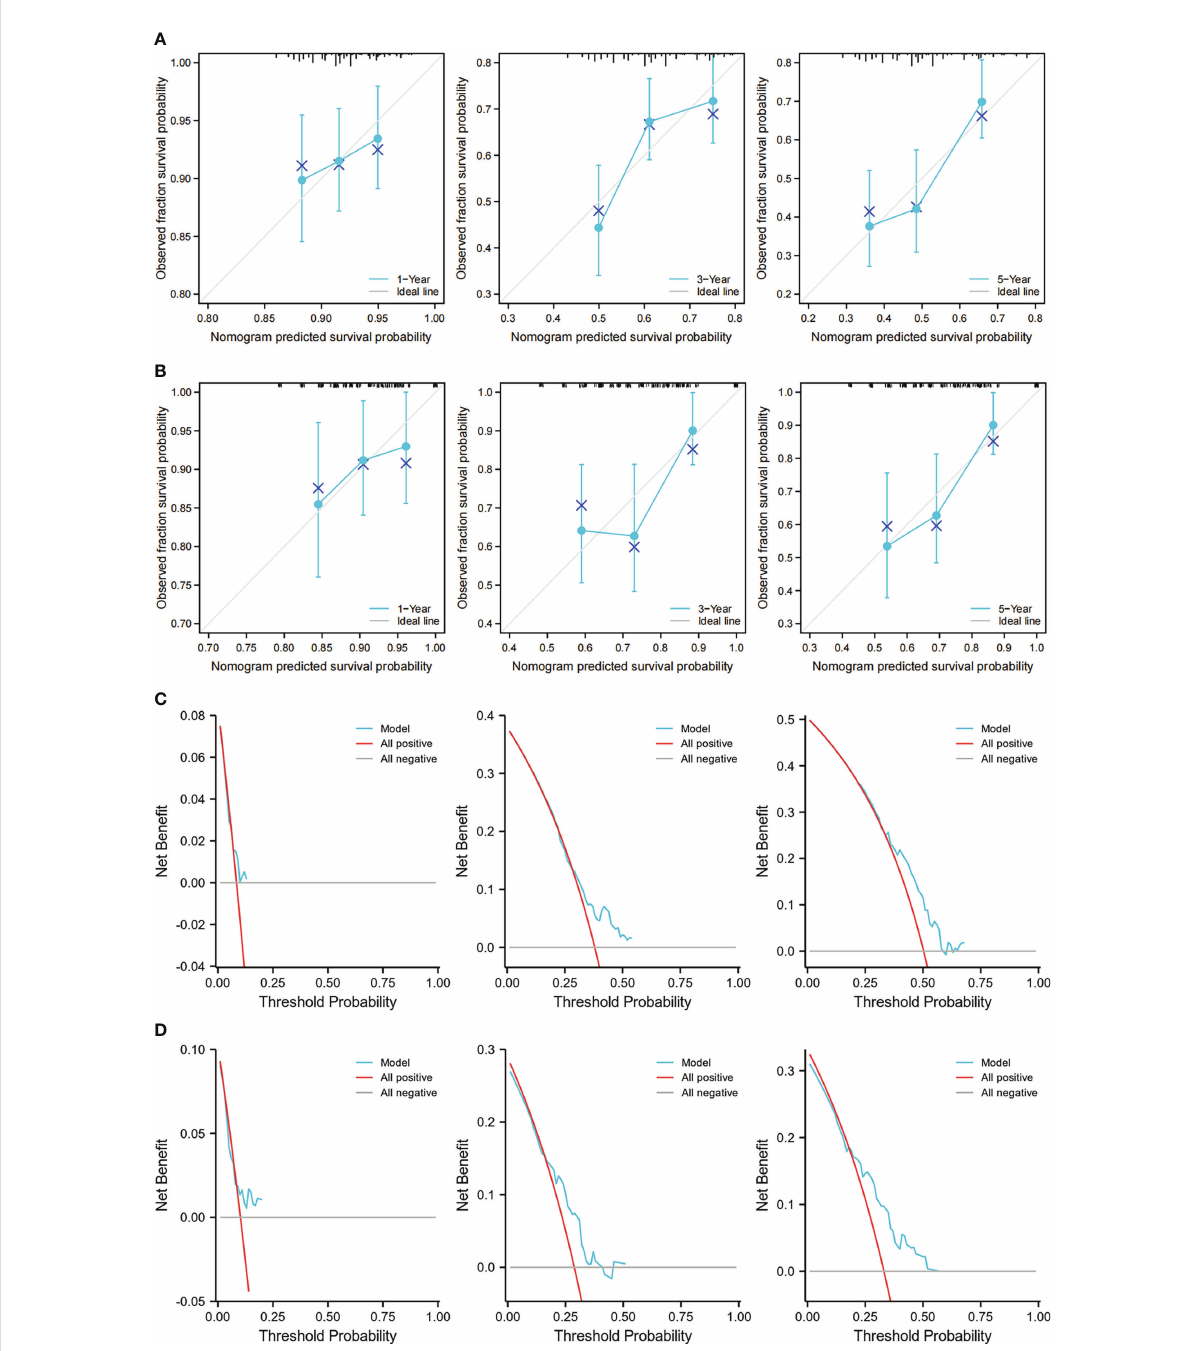
FIGURE 4 Calibration curves and decision curve analysis (DCA) of the nomogram. (A, B) Calibration curves showing the observation and prediction results of the 1-, 3-, and 5-year survival rates of patients in the training group (C-index = 0.594, 95% CI = 0.566 – 0.622) (A) and those in the validation group (C-index = 0.635, 95% CI = 0.582 – 0.688) (B) . (C, D) DCA of the nomogram for the 1-, 3-, and 5-year survival prediction of patients in the training group (C-index = 0.594, 95% CI = 0.566 – 0.622) (C) and those in the validation group (C-index = 0.635, 95% CI = 0.582 – 0.688) (D)